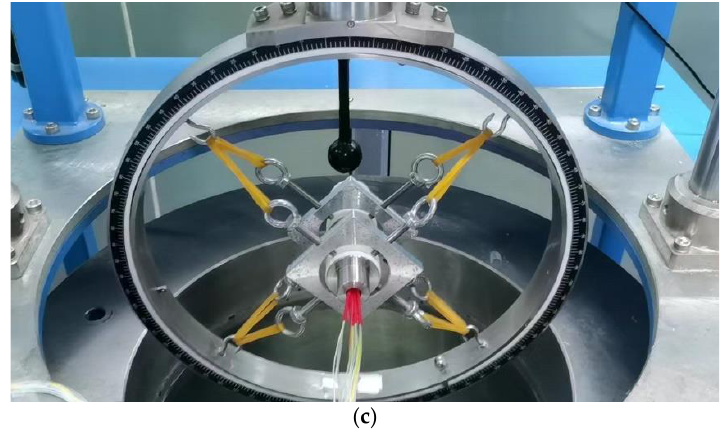
Figure 12. The vector hydrophone test device: ( a ) the FUVH distance from the water surface is d , and the reference hydrophone distance from the water surface is d 0 ; ( b ) the test device and ( c ) the FUVH elastically suspended from the revolver.